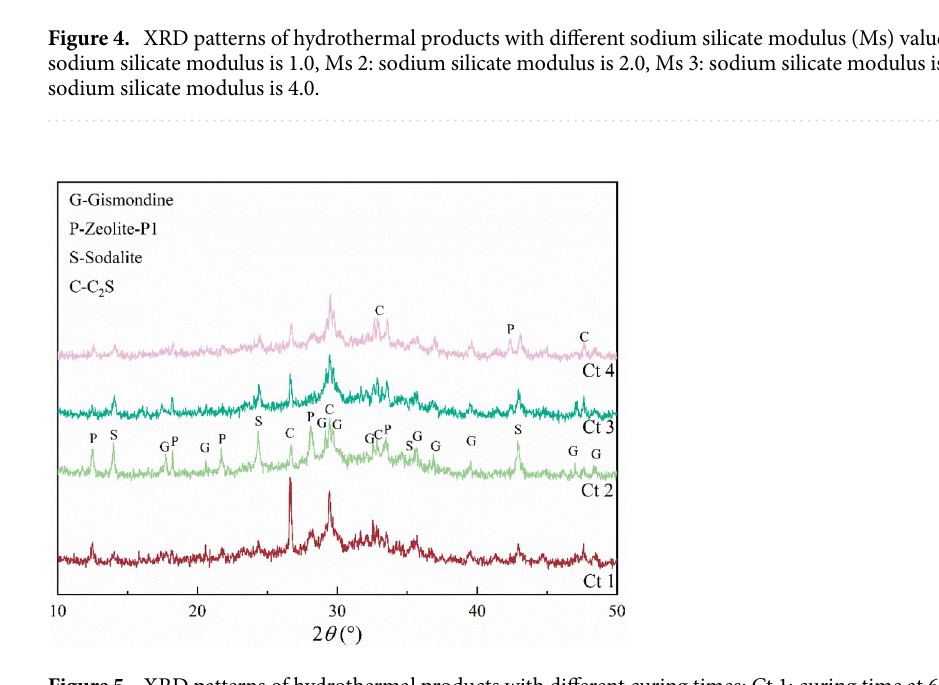
Figure 5. XRD patterns of hydrothermal products with different curing times; Ct 1: curing time at 6 h, Ct 2: curing time at 12 h, Ct 3: curing time at 18 h, Ct 4: curing time at 24